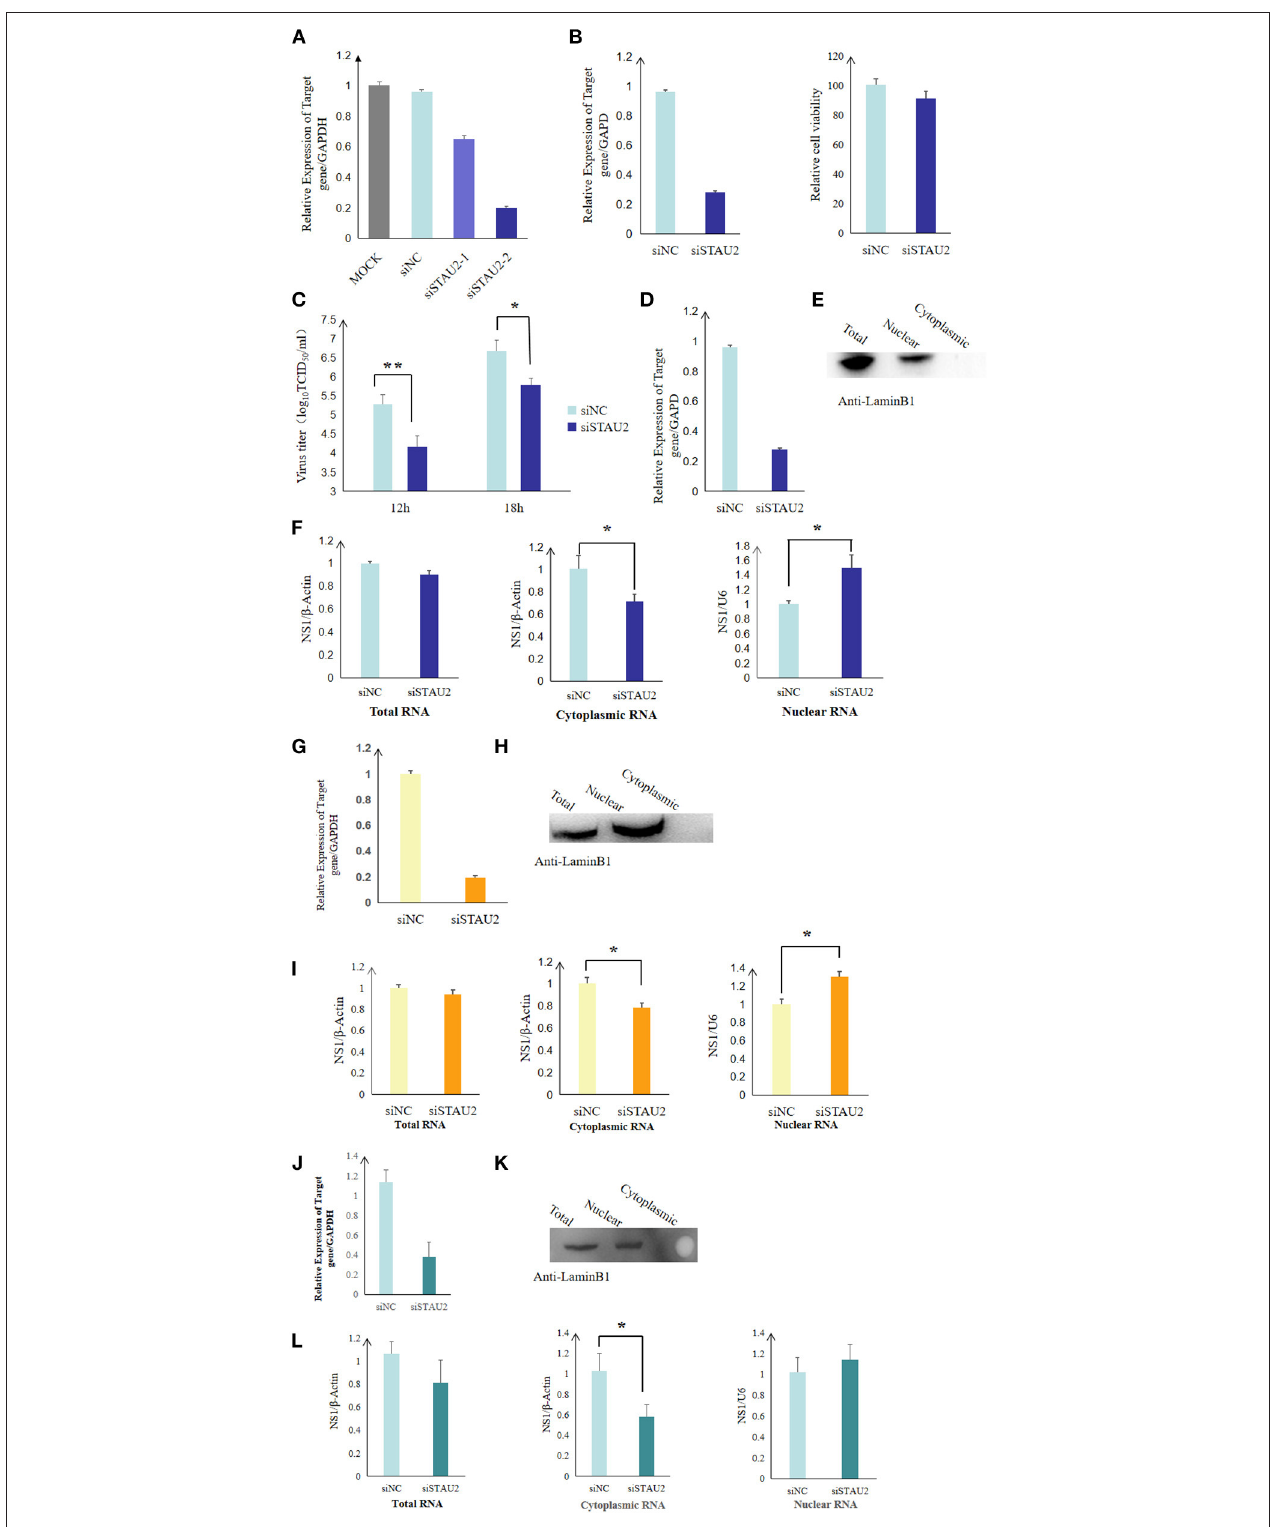
FIGURE 5 | STAU2 promotes the nuclear transport of NS1 mRNA and thereby promotes the replication of H5N1 AIV. The expression of STAU2 was dramatically reduced in the specific siRNA-treated DF1 cells (A) , and its downregulation had no major effect on cell viability (B) . (C) Progeny virus titers after transfecting DF1 cells with siSTAU2 and infecting them with H5N1 AIV for 12 or 18h. Chicken DF1 cells were treated with siSTAU2 or siNC for 12h, which dramatically reduced the